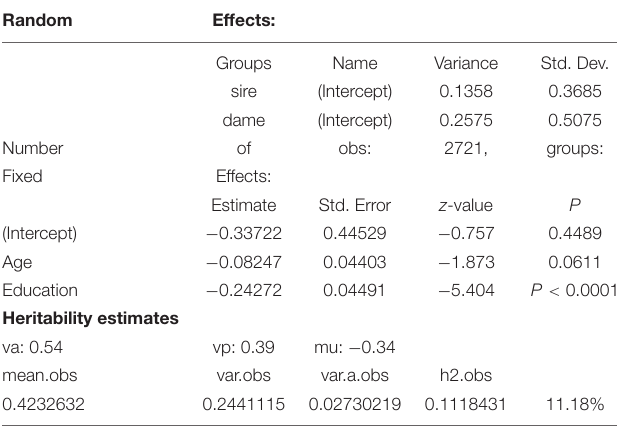
TABLE 9 | Estimates of social and genetic heritability by a general linear mixed model of HMM on Parent is Homogamous/Heterogamous (ParentalHomHetGam) controlling for age and